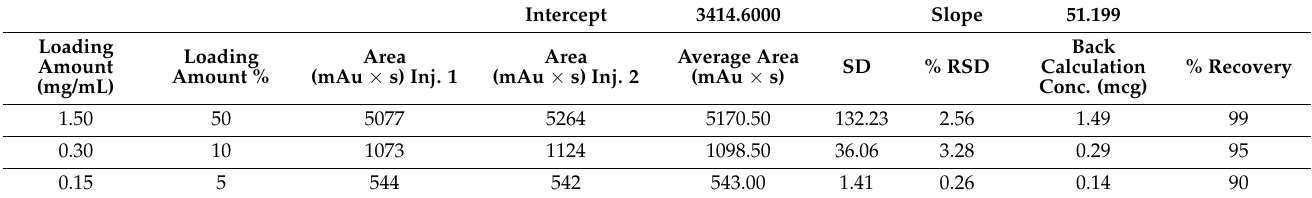
Table 3. % Recovery calculation from loading amount of 1.5 mg/mL to 0.15 mg/mL IgG1 sample on column. This data ensure that at 0.15 mg/mL of sample injection % recovery is 90%, which indicates the high sensitivity of the CEX UPLC method.